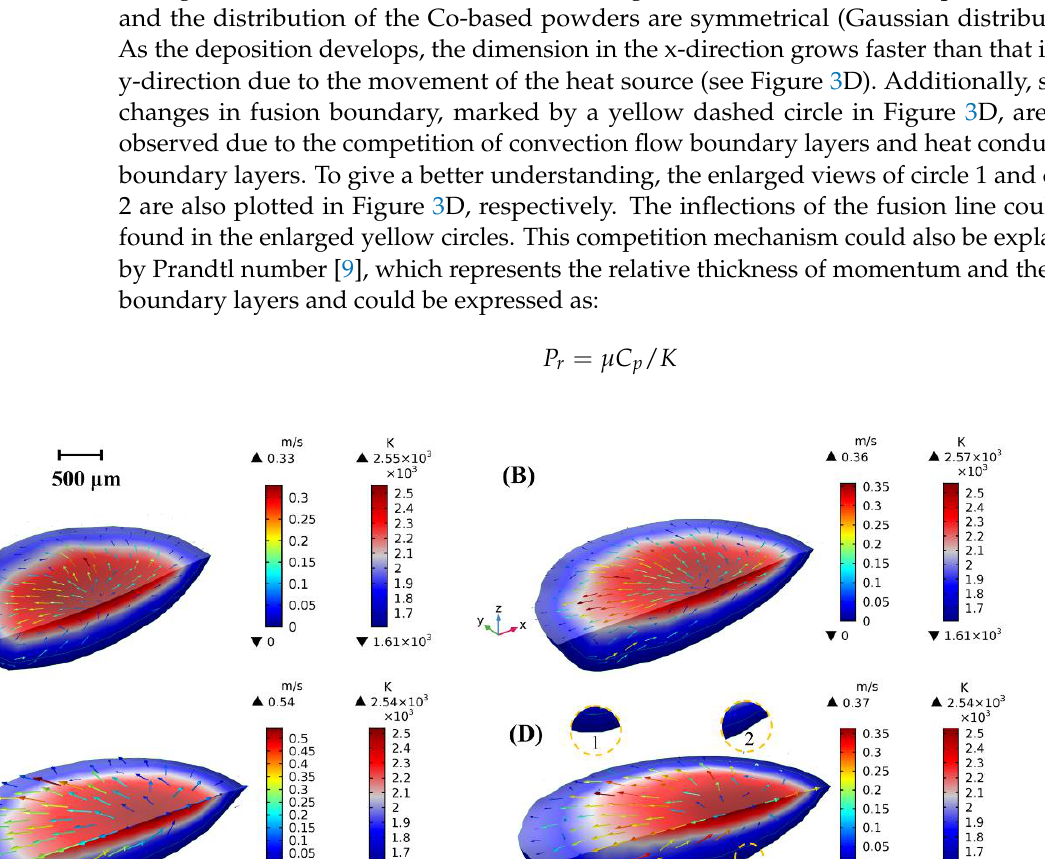
Figure 4. Cross-section of deposited track. ( A ) Experimental result [18; ( B ) Calculated result. Re- printed with permission from ref. [18]. Copyright 2017 Elsevier